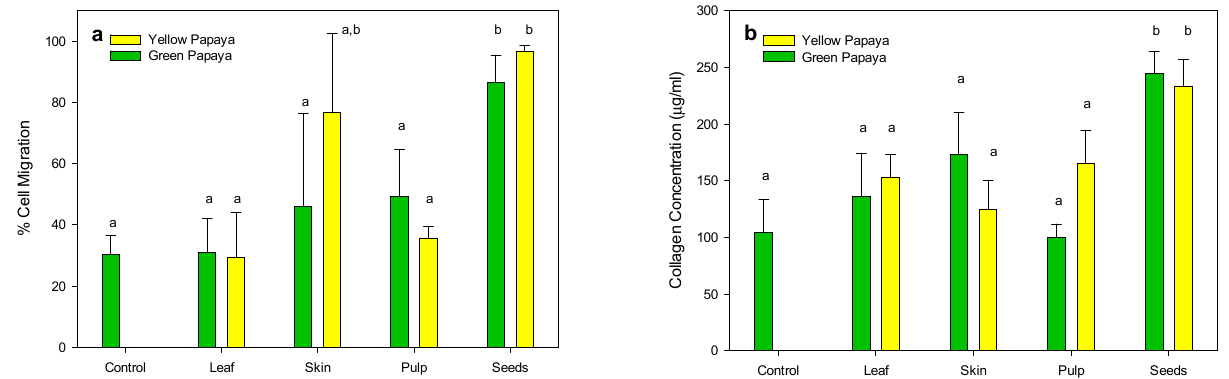
Figure 10. Wound-healing properties of papaya fractions. The wound-healing properties of meth- anolic extract of leaf, skin, pulp, and seed (100 μ g/mL) were demonstrated using human fibroblast (HFF-1) cells in an in vitro scratch assay by measuring cell movement in the scratch area ( a ) and by assaying collagen synthesis ( b ) as described in the text. Statistical analysis of data was performed using one-way ANOVA (analysis of variance) with Tukey’s HSD post hoc test ( n = 3). The statistically significant difference at p < 0.05 within and between groups was represented by different letters compared to the vehicle-treated control.